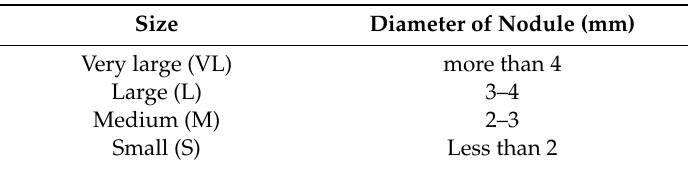
Figure 1. Plant growth and symbiotic parameters of soybean cultivar Chiang Mai 60 and Enrei by co-inoculation with S141 and USDA110 at 45 DAI: ( a ) nitrogenase activity was determined using the acetylene reduction assay; ( b ) nodule numbers per plant; ( c ) nodule dry weight; ( d ) root dry weight; ( e ) total plant dry weight; and ( f ) nodule size separation. Significance at p ≤ 0.05 is indicated by mean standard error bars (n = 8) of soybean cultivar Chiang Mai 60 and (n = 6) of soybean cultivar Enrei. Table 2. Size of soybean